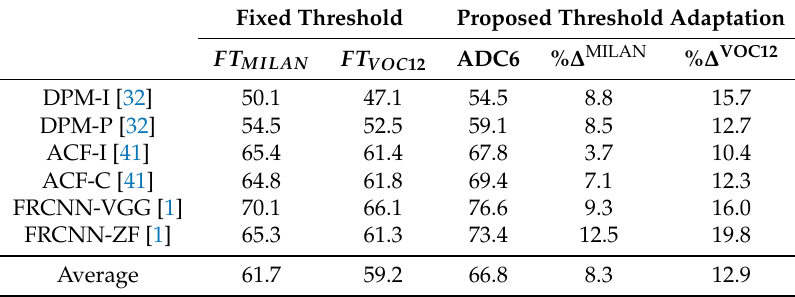
Table 6. Comparison in terms of average FScore between two fixed thresholding approaches and the ADC6 over MILAN dataset. Percentage increase (% ∆ MILAN and % ∆ VOC12 ) calculated with respect to the fixed thresholding approaches, FT MILAN and FT VOC 12 ,